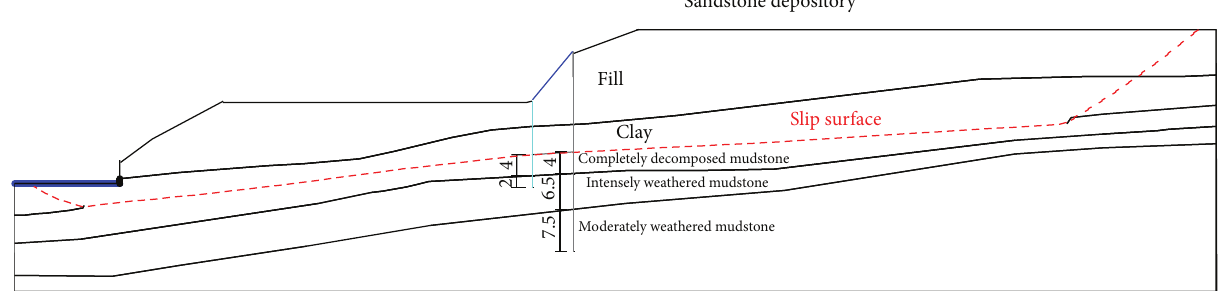
Figure 4: Scheme of portal double-row piles used to stabilize a landslide (units: m).